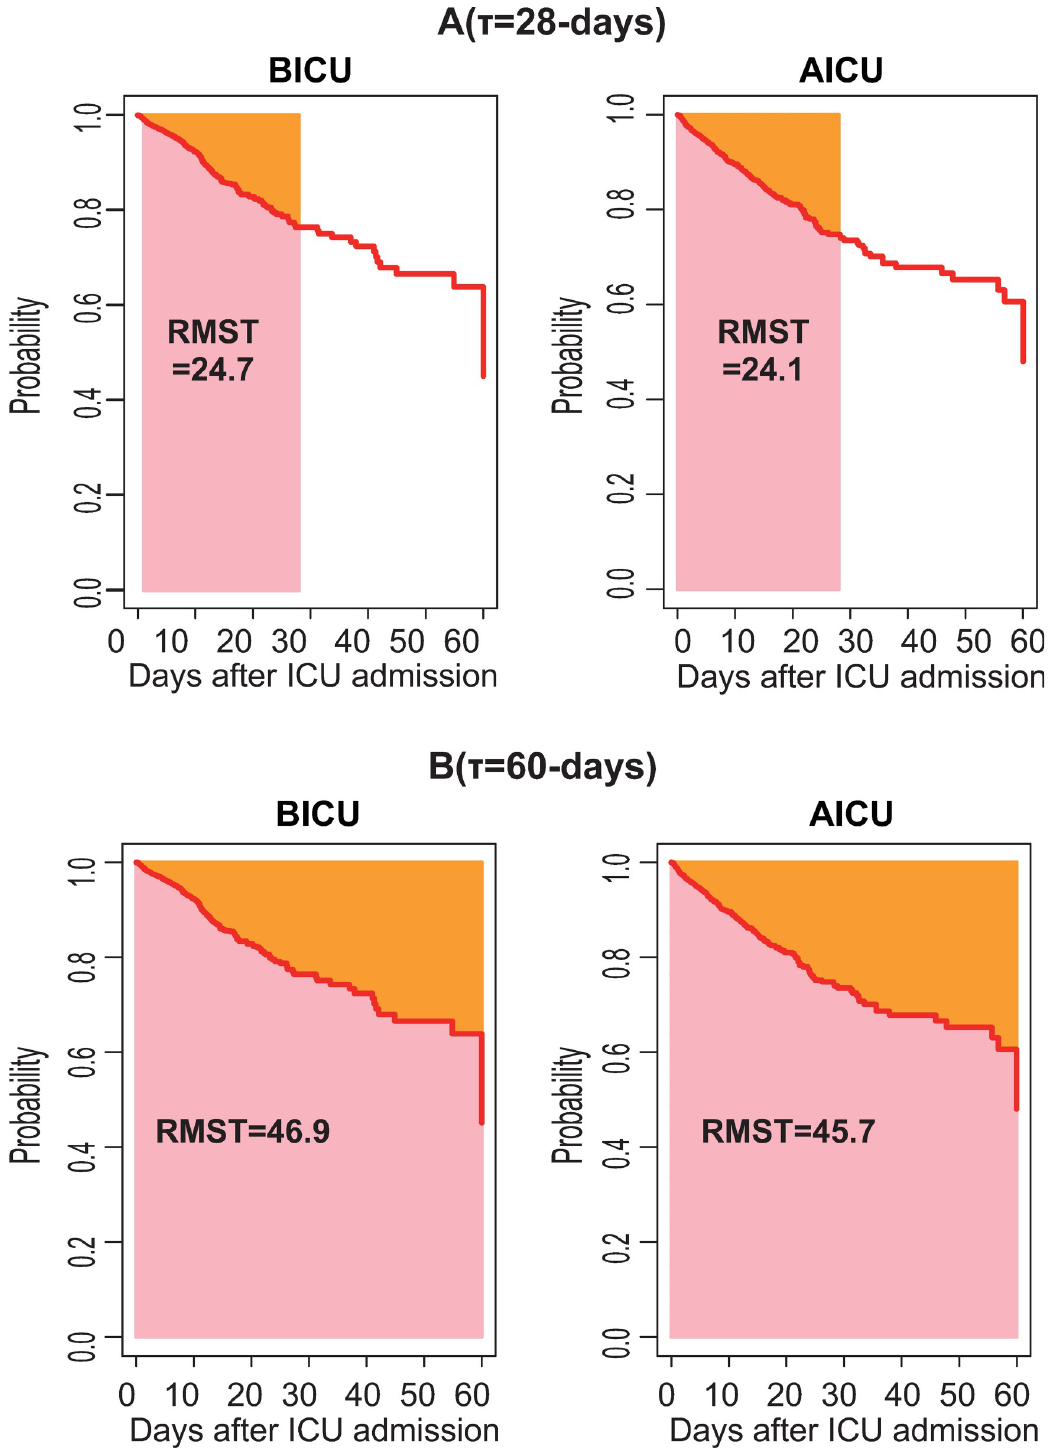
Fig 2. Comparisons of restricted mean survival time (RMST) for τ = 28-days(A) and τ = 60-days(B) between the two group in the PSM cohort (n = 9,510).